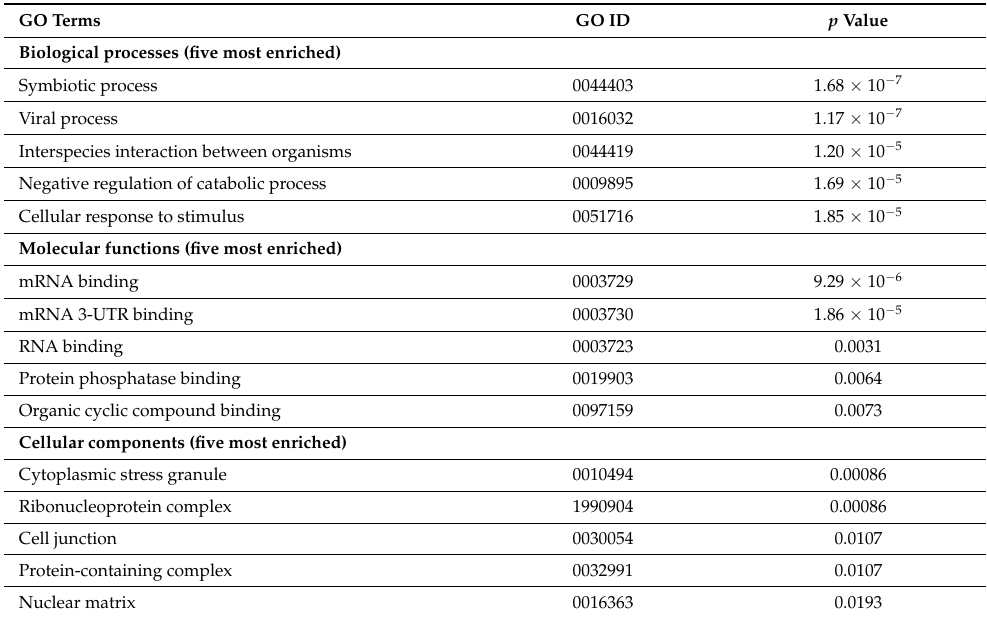
Table 2. GO annotation results for the “internal” interaction network. The table shows the five most enriched terms for biological processes, molecular functions, and cellular components among the network of reciprocal interactions predicted by STRING for the 17 human proteins considered in this study. In order to include all proteins in the network, the minimum required interaction score: low confidence (0.150) was used.